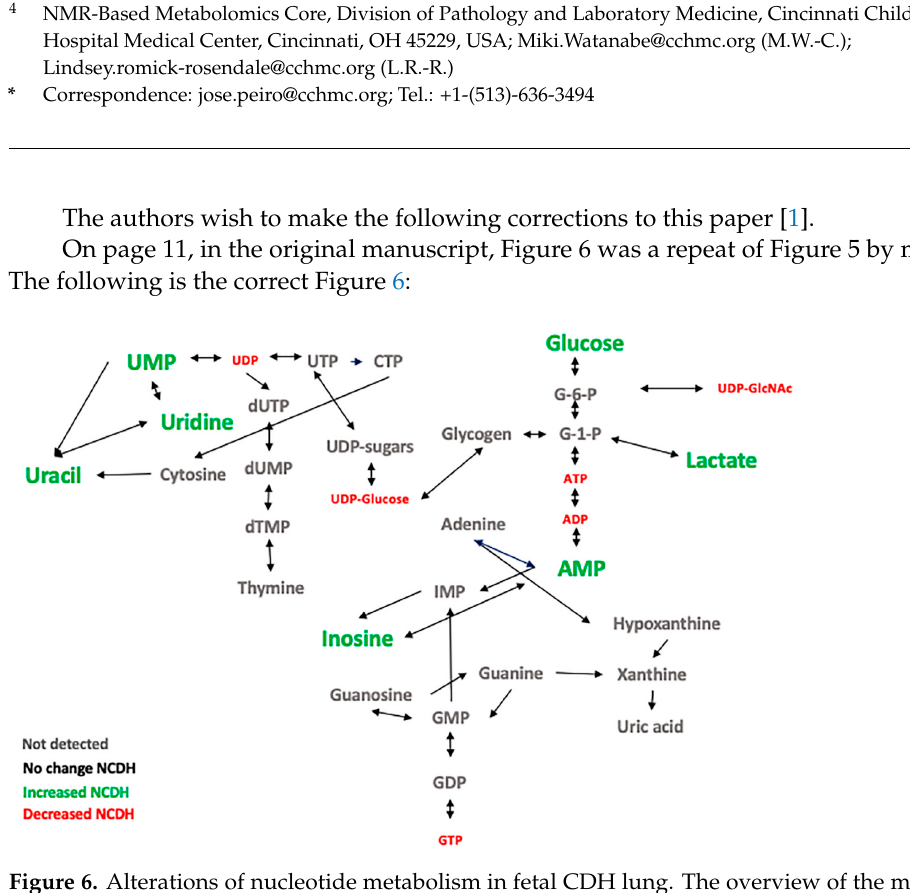
Figure 6. Alterations of nucleotide metabolism in fetal CDH lung. The overview of the metabolic flow of nucleotide metabolites and changes identified in the NCDH group compared with the VC group. Green (increased), red (decreased), black (no change), and grey (undetected). Conflicts of Interest: The authors declare no conflict of